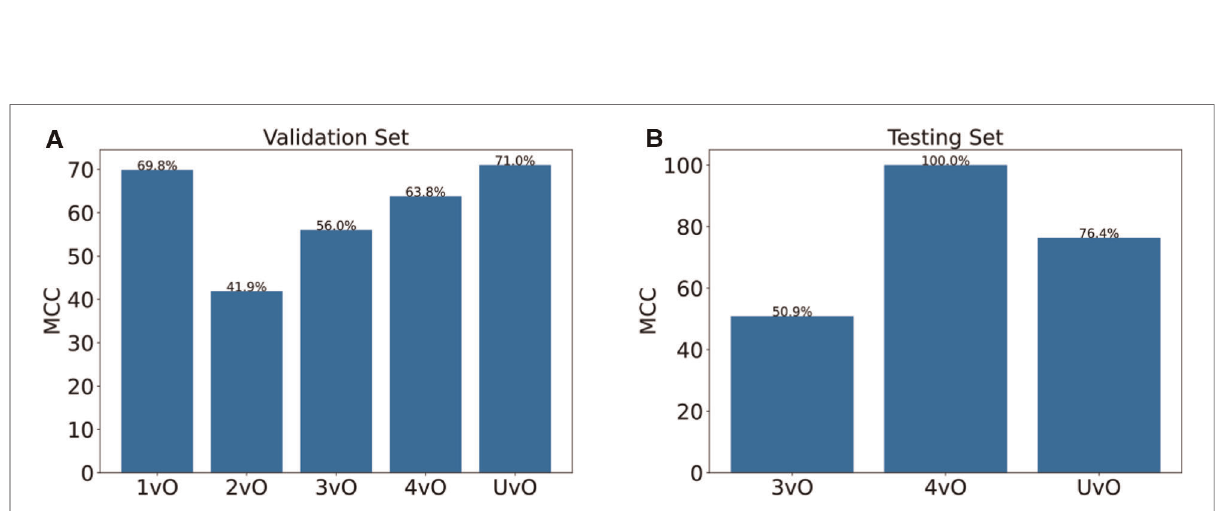
FIGURE 3 Matthews correlation coef fi cient (MCC) of ( A ) validation set of 144 photos, and ( B ) testing set of 10 photos. 1vO: Stage 1 vs. Others; 2vO: Stage 2 vs. Others; 3vO: Stage 3 vs. Others; 4vO: Stage 4 vs. Others; UvO: Unstageable vs. Others.